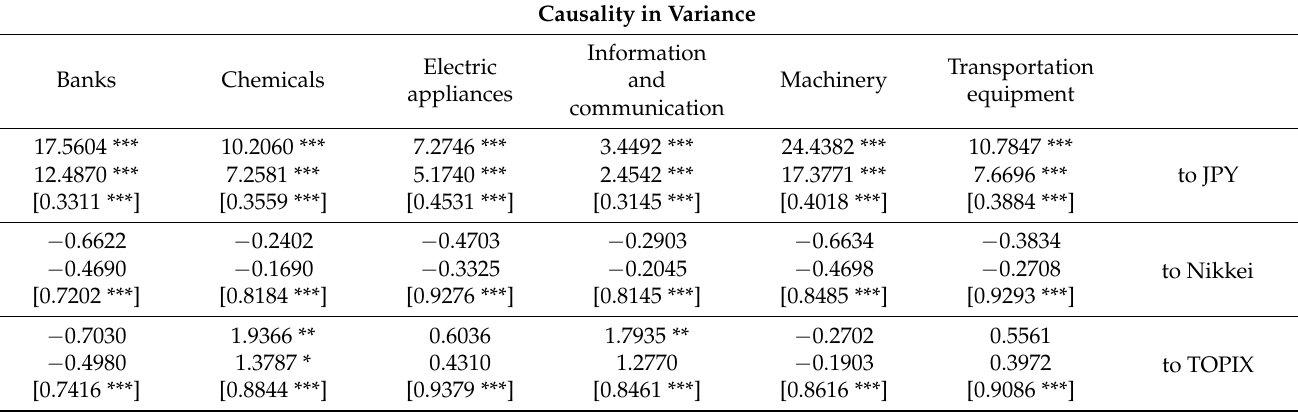
Table 6. Causality from sectoral indices to JPY, Nikkei, and TOPIX. Author’s estimations. First line reports Hong’s (2001) Q-statistics with truncated kernel. Second line reports Hong’s (2001) Q-statistics with Bartlett kernel. Third line reports cross-correlation coefficients at lag 0 (contemporaneous correlation). ***, ** and * indicate that the null hypothesis of no causality (from lag 1 to lag 10 for Hong’s (2001) Q-statistics) at the 1%, 5%, and 10% significance levels, respectively, is rejected.